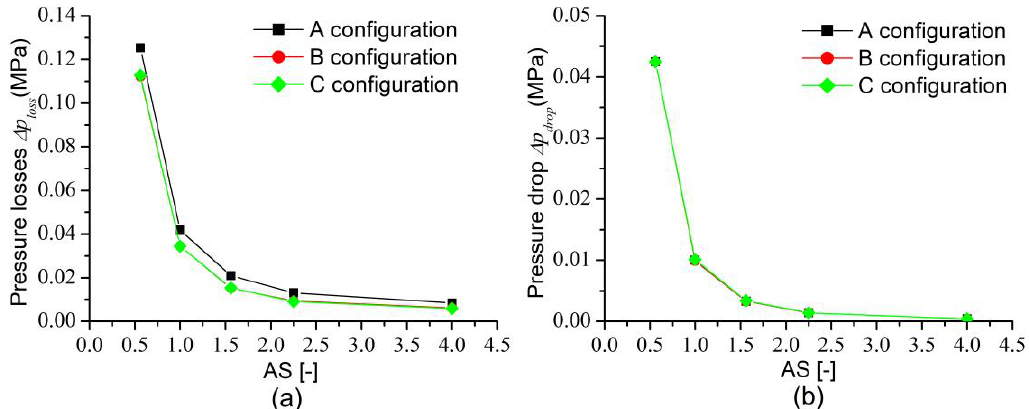
Figure 11. Influence of main pipe diameter on: ( a ) pressure loss; ( b ) pressure drop.